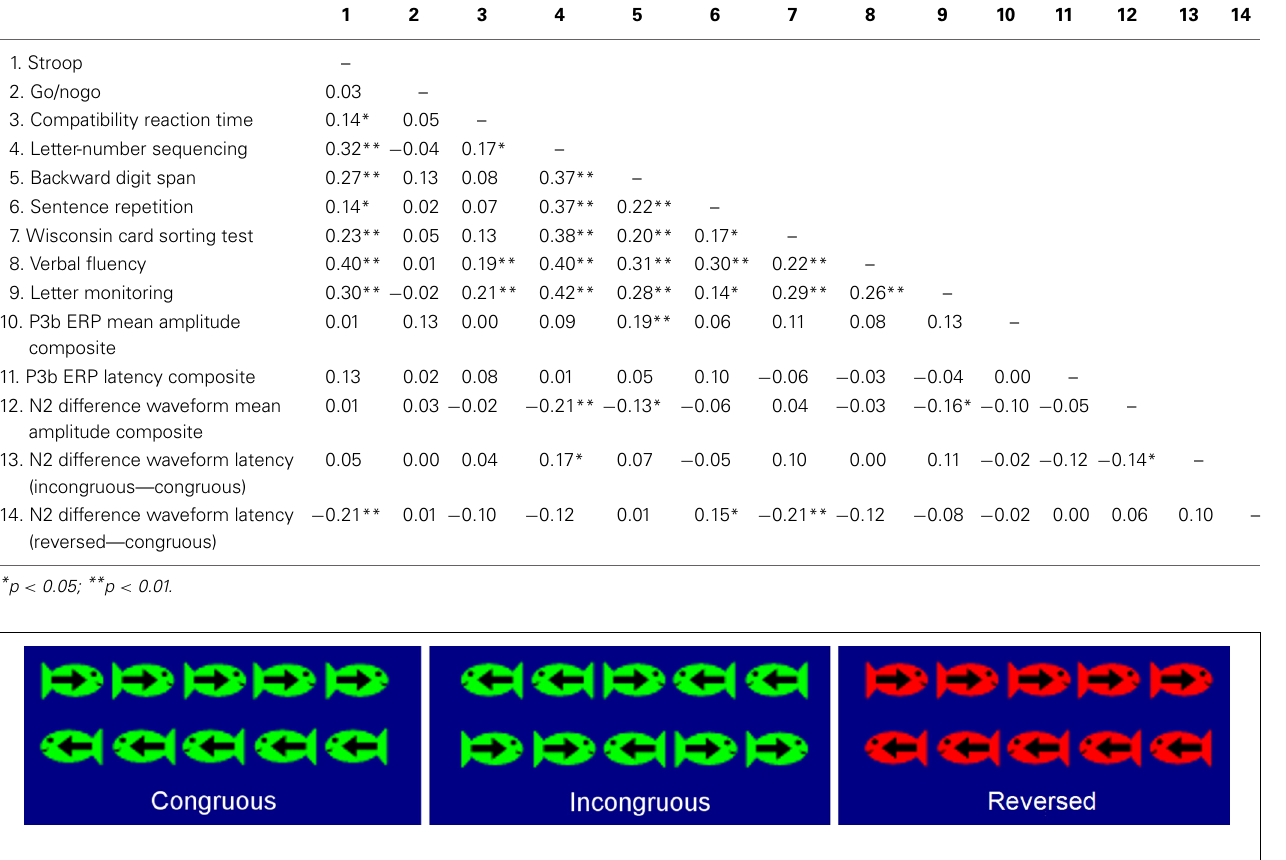
individual ERP averages of the incongruous and reversed